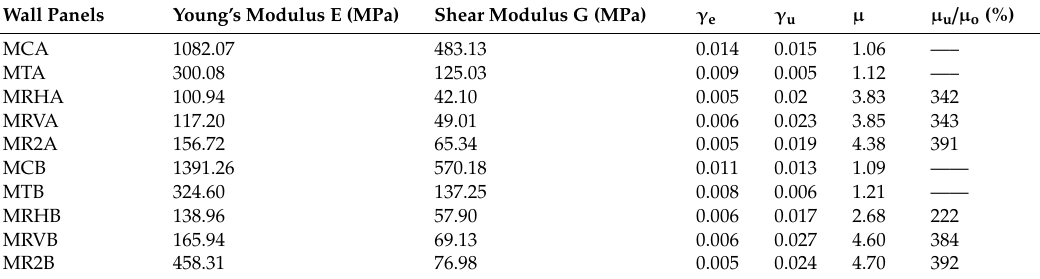
Table 7. Comparison of the displacement ductility factor of all tested masonry panels.